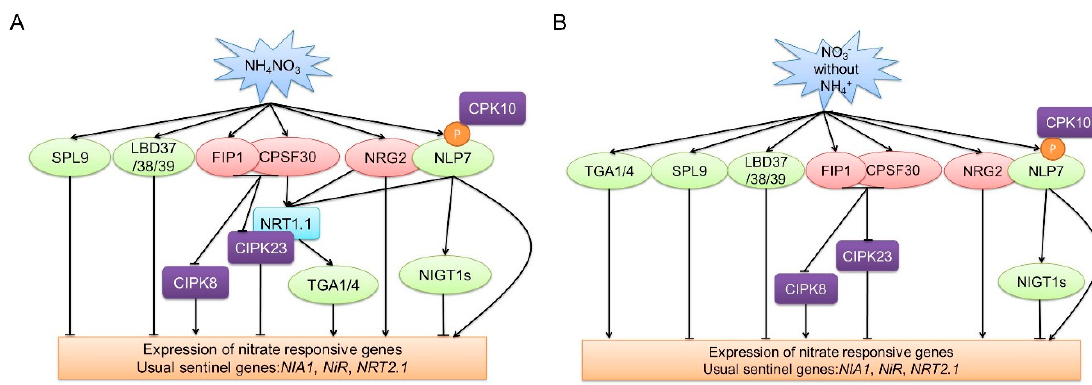
Figure 1. Schematic representation of nitrate regulatory factors affecting nitrate signaling. ( A ) The schematic for nitrate regulatory factors in the present of both ammonium and nitrate; ( B ) the schematic for nitrate regulatory factors without ammonium. The blue box indicates a nitrate sensor. Light green boxes indicate transcription factors. Purple boxes indicate protein kinases. Light red boxes indicate other nitrate signaling regulators. Arrows indicate positive regulation. Blunted lines indicate negative regulation.